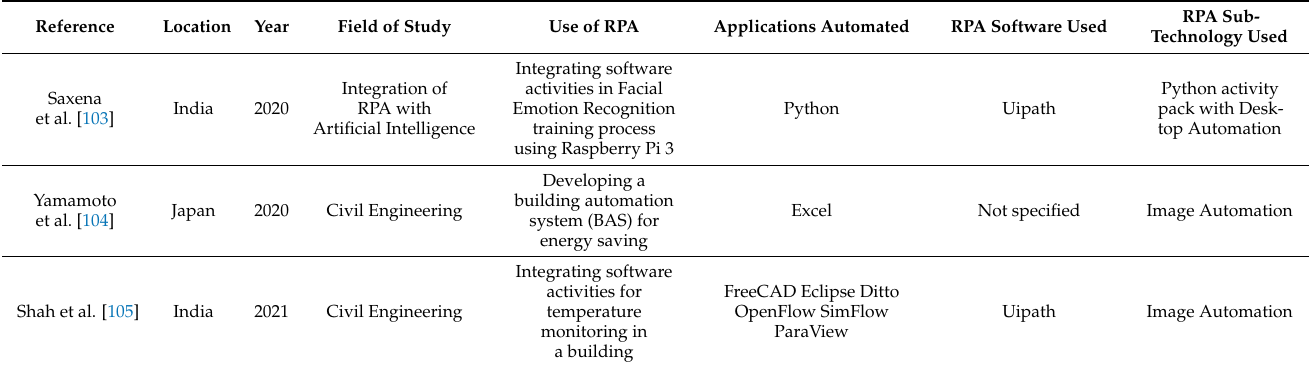
Table 3. Related papers with civil engineering, sensors, and process